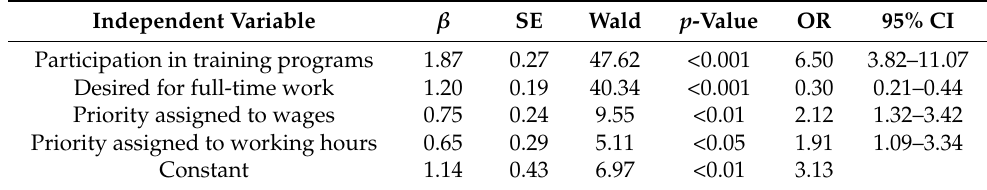
Table 5. Relevant factors concerning employment status using multiple regression